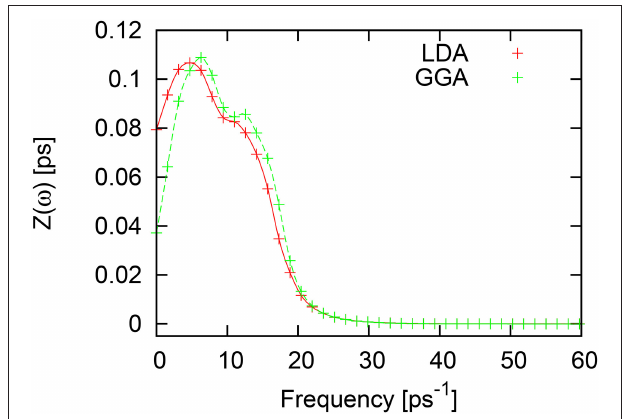
FIGURE 10 | Fourier spectrum of velocity autocorrelation function for liquid Tl with LDA (red symbols and solid line) and GGA (green symbols and dashed line).